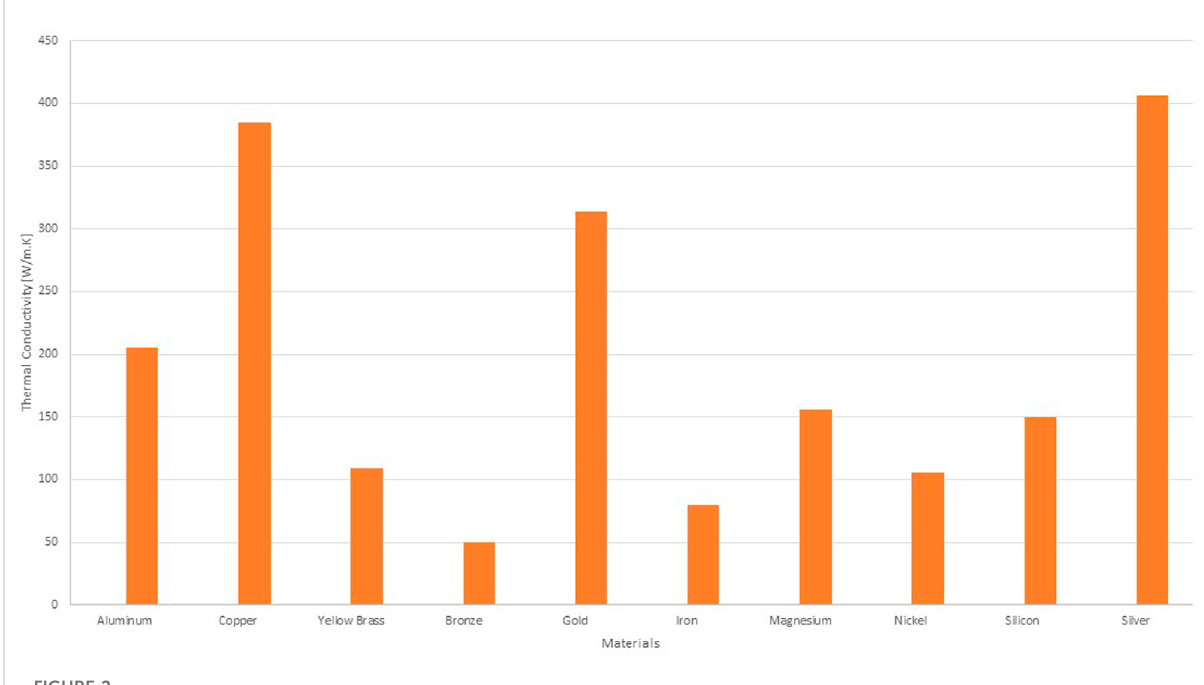
FIGURE 2 Thermal conductivity of commercial